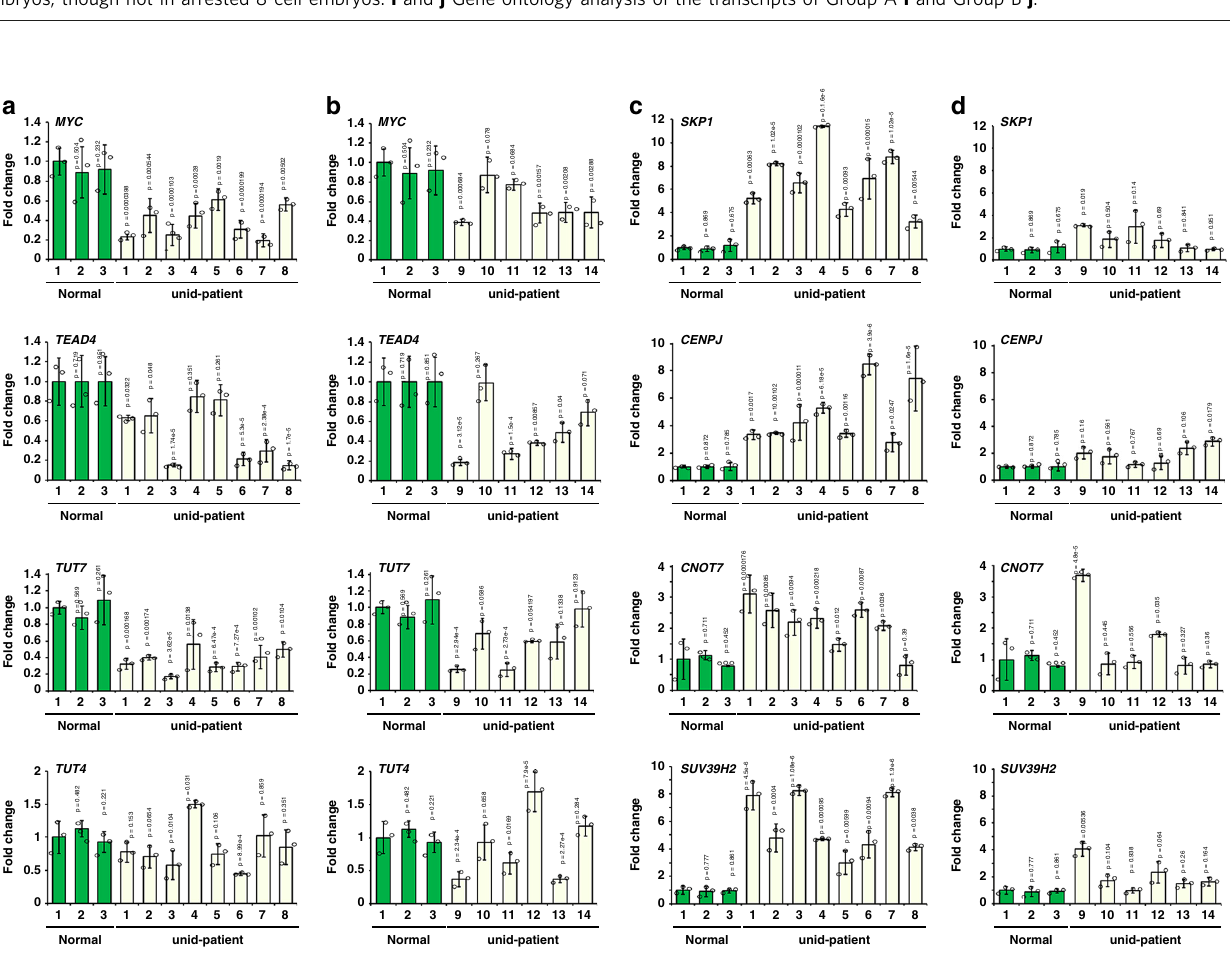
Fig. 9 Levels of Z-decay-related transcripts in human embryos after IVF. a and b The RT-qPCR results show the mRNA levels of key zygotic factors in normal and 8-cell stage-arrested embryos. 1 – 3, normal 8-cell embryos; 1 – 14, 8-cell stage-arrested embryos from different patients. c and d The RT-qPCR results show the mRNA levels of selected Z-decay transcripts in normal and 8-cell stage-arrested embryos. Data are presented as mean values± SEM. P by one way ANOVA. n.s. non-signi fi cant. n = 3 independent